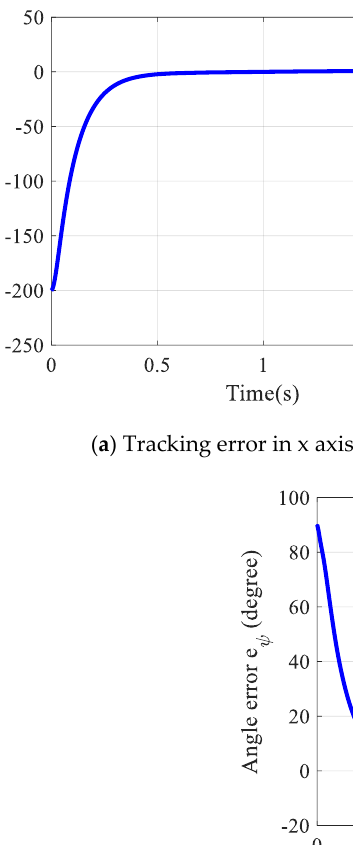
Figure 3. Tracking histories of controlled AUSV: proposed method (blue solid line) and desired trajectory (black dashed line).